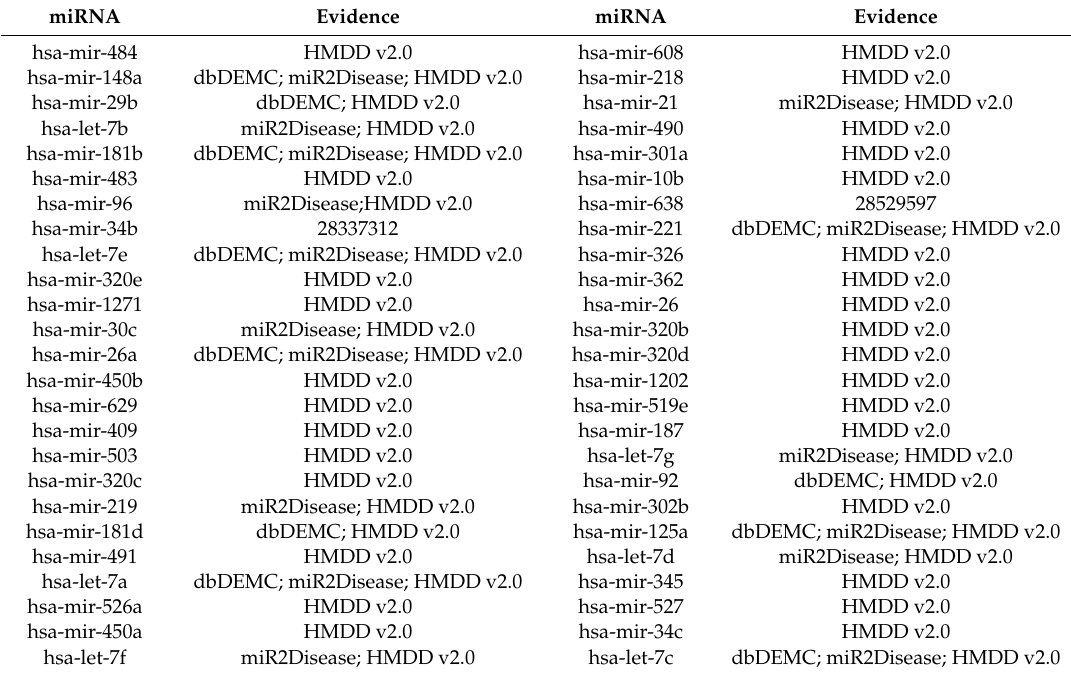
Table 2. Prediction of the top 50 potential HC-related